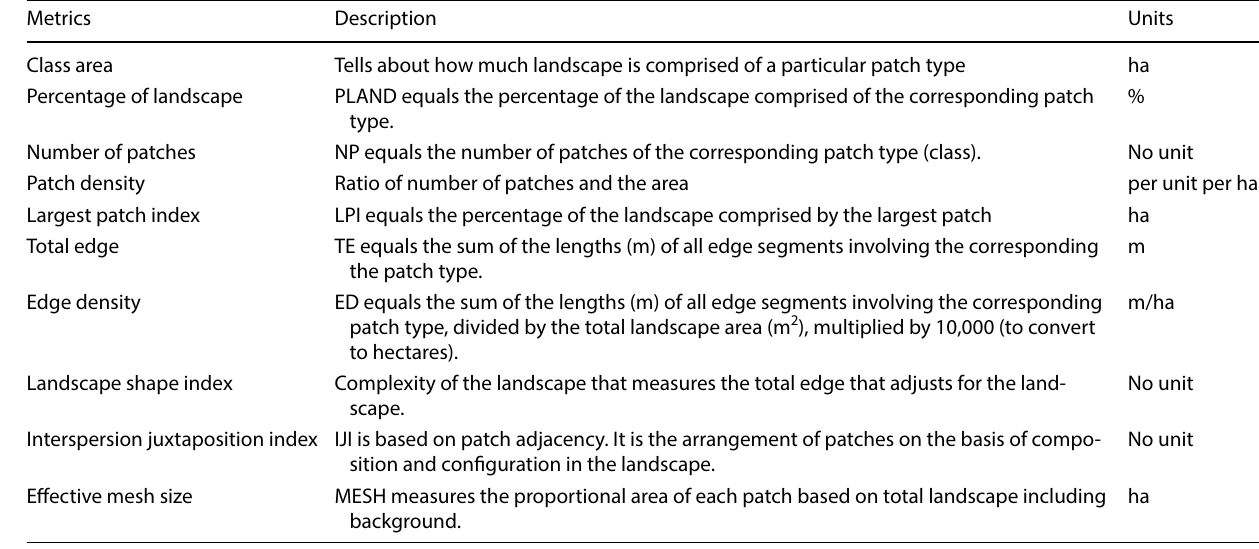
Landscape shape